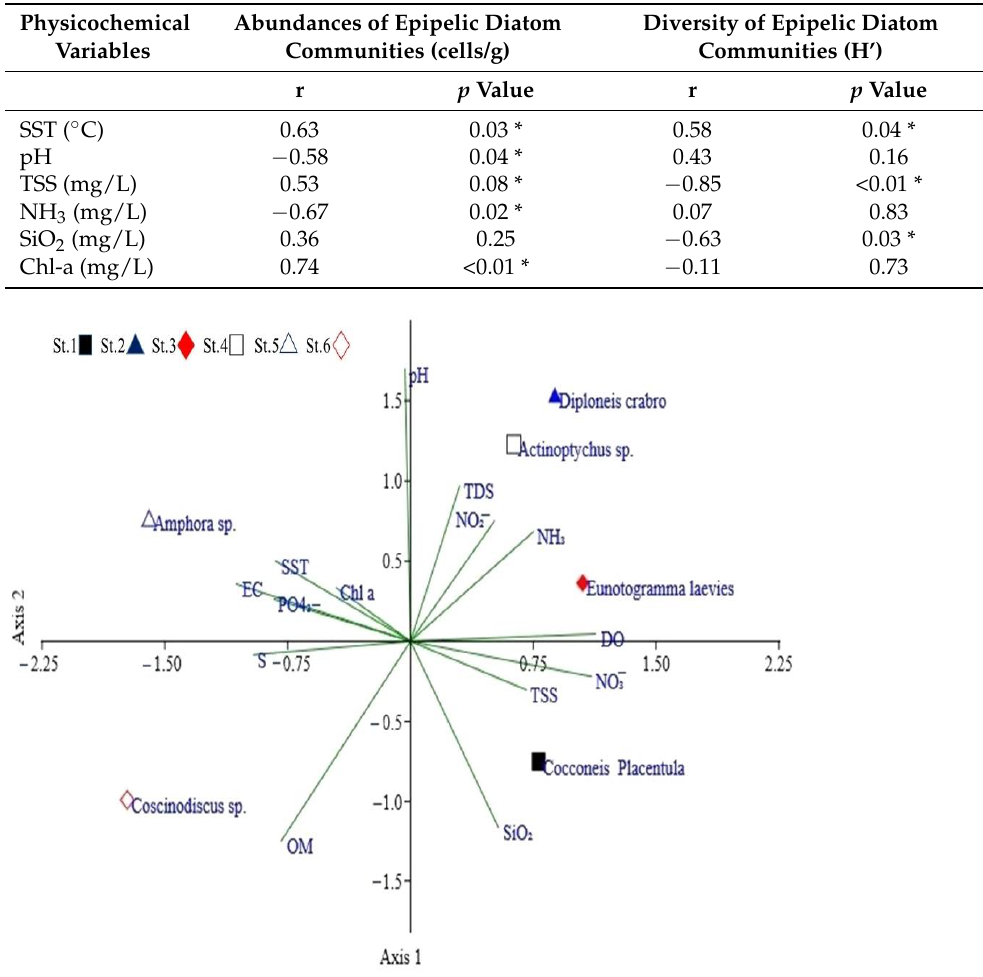
Figure 6. Principal component analysis ordinations of the dominant epipelic diatom species and physiochemical variables measured at six stations along the Port Dickson coasts, Malaysia.